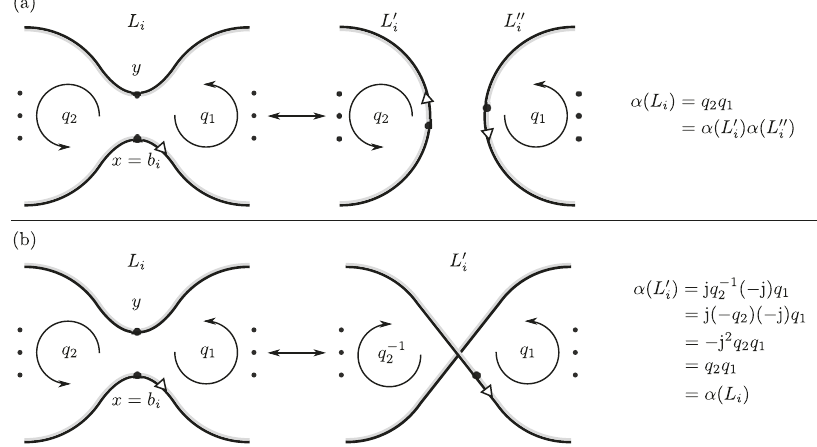
Fig. 11 Conservation of the colored invariant Q gray in topologically allowed reconnections. a , b The cases to consider. The difference between them is the total number of times L i crosses under a red or a blue strand, modulo 2, when traversing from the point x to y . a In the case of an even number, the loop L i splits into two loops L 0 and L 00 . b In the case of an odd number, the quaternions q i anticommute with j and q (cid:2) 1 i i deduce the conservation of the invariant Q gray